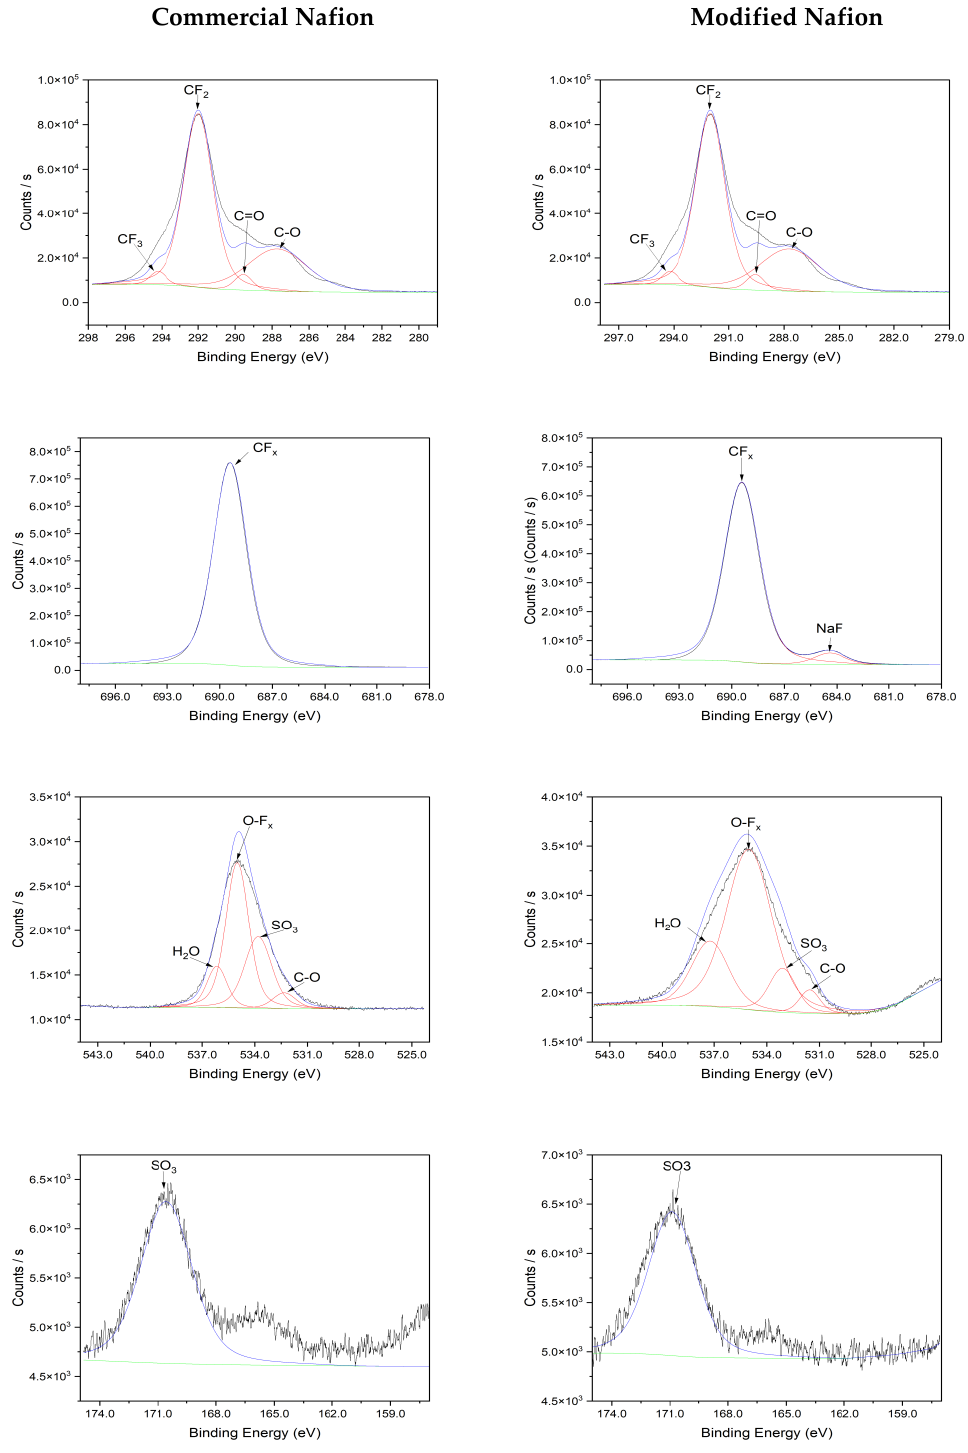
Figure 6. XPS high resolution scans of the commercial Nafion ( left ) and modified Nafion ( right ). From top to bottom: carbon—C1s, fluorine—F1s, oxygen—O1s and sulfur—S2p. The black curve in all sub-figures is the scan data; the blue curve is the fitted data; the red curves are the deconvoluted peaks, and the green curve is the baseline.